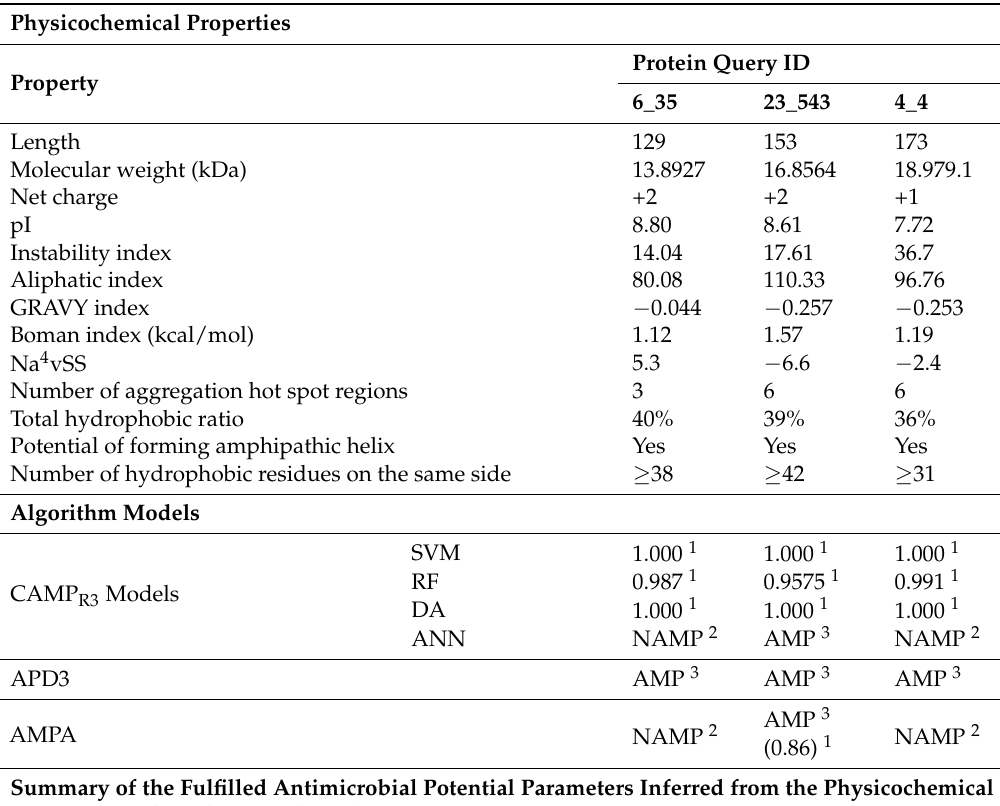
Table 2. Prediction of the antimicrobial potential of the uncharacterized proteins based on their physicochemical properties and algorithm